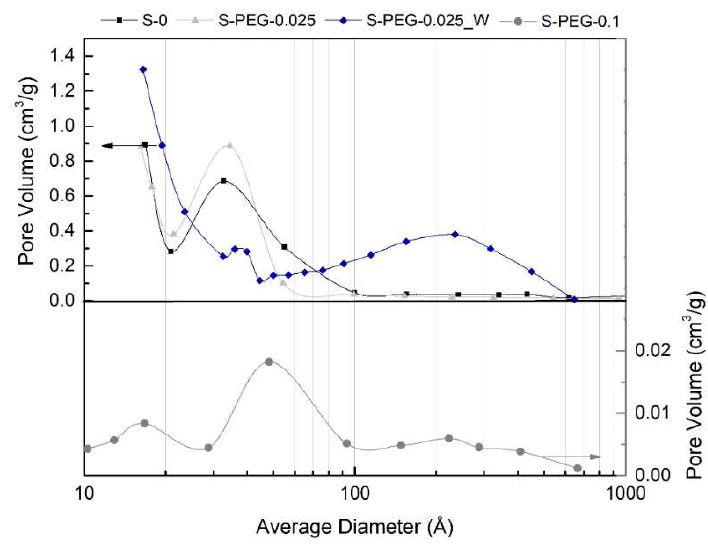
Figure 9. Pore size distributions of aerogel-like materials with and without PEG additive.